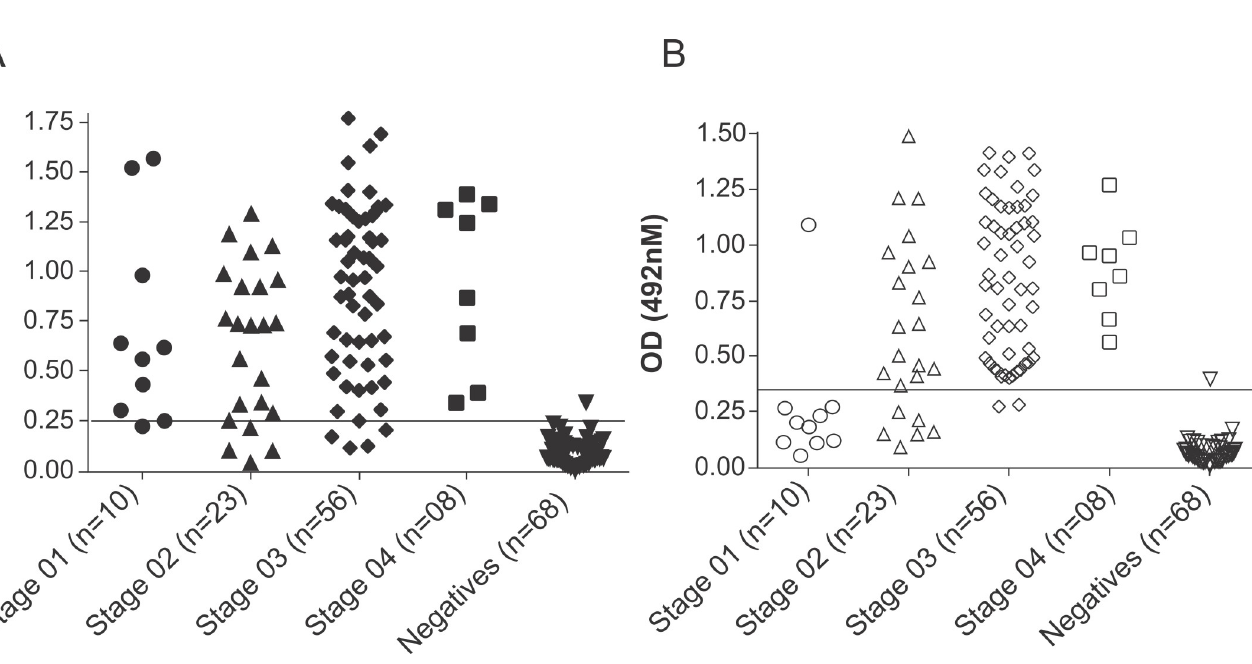
Fig 6. Evaluation of the performance of (A) the LPG-ELISA and (B) the identification of L . infantum -specific immunoglobulins in dogs with different stages of canine visceral leishmaniasis. The dogs underwent clinical staging based on their clinical signs and clinical pathology profiles. The lines within the graphs represent the established cut-off for each